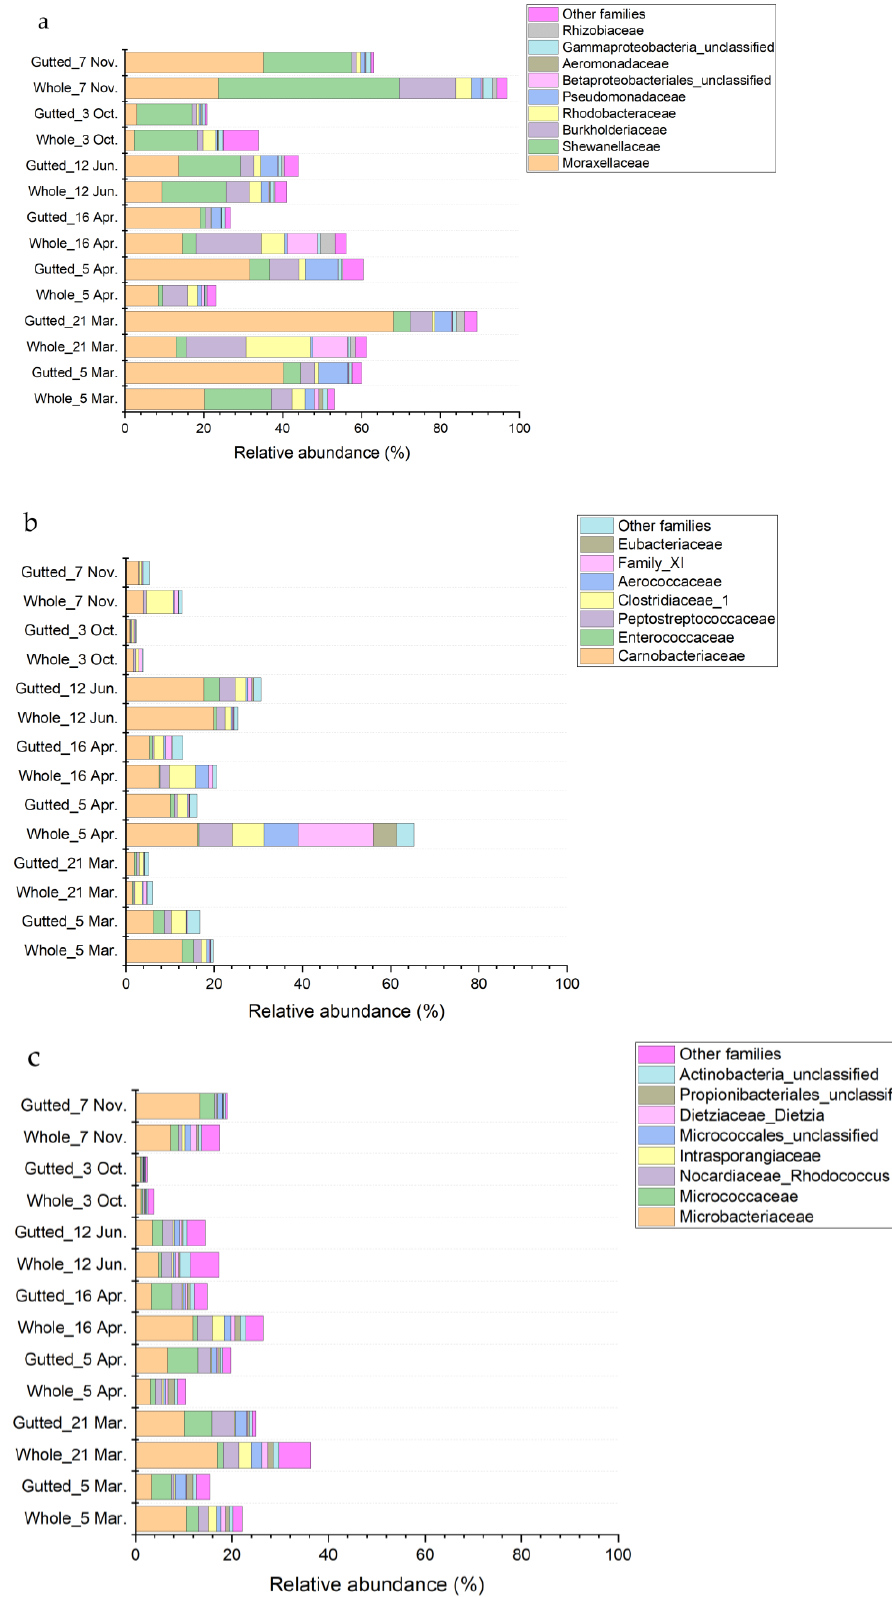
Figure 5. Bacterial population composition of the whole and gutted herring identified with 16S rRNA gene amplicon sequencing. The phyla Proteobacteria ( a ), Firmicutes ( b ), and Actinobacteria ( c ) are presented at the family level. Each batch is an average of four to six whole and gutted fish. Major classes belonging to the phylum Firmicutes were Clostridia and Bacilli (Figure 5), which together represented 2.3% to 30.7% of the total bacterial community, except for the whole herring on 5 April, where the proportion of the phyla represented up to 65.2% of all the sequences. In that sample, clostridial families Peptostreptococcae (most abun- dant genera Proteocatella , Peptostreptococcus , and Acetoanaerobium ), Family XI (mainly ge- nus Gottschalkia ), Eubacteriaceae (mainly genus Acetobacterium ), and Clostridiaceae_1 (most abundant genera Proteiniclasticum , Clostridium_sensu_stricto_13, and Clostrid- ium_sensu_stricto_5) accounted for over 30% of the bacterial population. In most samples, the majority of sequences assigned to the phylum Firmicutes belonged to the class Bacilli, in which the family Carnobacteriaceae (mainly genera Carnobacterium and Trichococcus ) was the most represented and covered up to 19.9% of all sequences. The phylum Actinobacteria was present in all the samples with a 10.4% to 30.8% share except for the 3 October samples, when the phylum was less than 4% of the total population. The phylum was mostly represented by the class Actinobacteria (Figure 5), in which the majority of the sequences belonged to the family Microbacteriaceae (not iden- tified at genus level), Micrococcaceae (mainly genus Arthrobacter ), and Nocardiaceae (only genus Rhodococcus ). Phylum Epsilonbacteraeota was dominant in the 3 October samples and accounted for 13.8% to 23.2% of all sequences in the 21 March whole herring, 16 April gutted herring, and 12 June samples. A total of 98.0% of the sequences assigned to the phylum were rep- resented by the family Arcobacteraceae, in which all the OTUs belonged to the genus Arcobacter . 4. Discussion In this study, the microbiological quality of several commercially fished herring batches was analysed. The batches were randomly selected, and they represented differ- ent seasons, as the aim of this study was to investigate whether the quality of the whole herring was acceptable for food use throughout the year as such, without further pro- cessing. The aerobic mesophilic and psychrotrophic bacteria levels detected in this study were similar to those reported previously for fresh herring aerobically stored in ice [17 – 20]. The EU regulation on the microbiological criteria for foodstuff ((EC) No. 1441/2007)